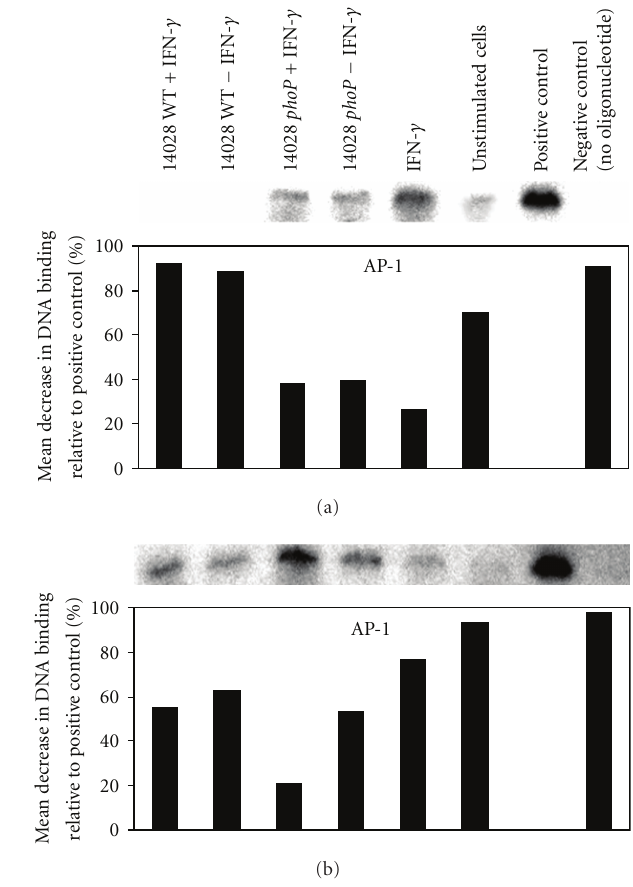
Figure 3: Wild type S. typhimurium suppress NF κ B/DNA interac- tion in J774.2 cells 2 and 12 h afterculture via phoP . (a) 2h postcul- ture. (b) 12 h post-culture. Controls include, uninfected J774.2 cells, manufacturers kit positive control (HeLa cell nuclear lysate with oligonucleotide), and manufacturers kit negative control (HeLa cell nuclear lysate without oligonucleotide). Data is representative of EMSAa performed on 3 separate occasions.